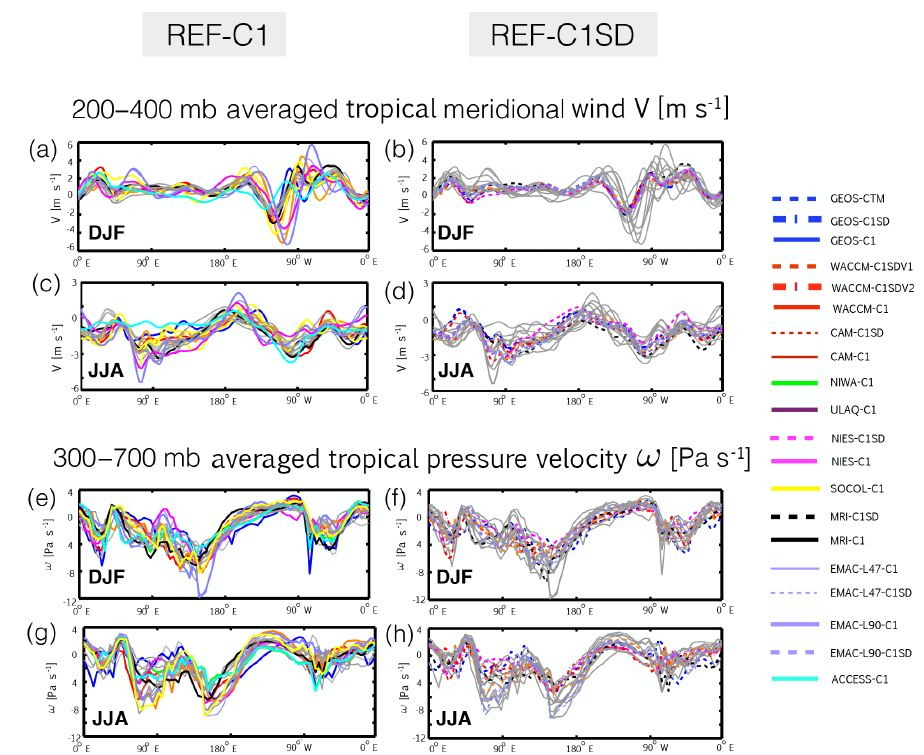
Figure 10. Comparisons of the upper tropospheric meridional wind V (a–d) and 300–700hPa averaged pressure velocity (e–h) among the simulations. The REF-C1 and REF-C1SD simulations are shown in panels (a, c, e, g) and (b, d, f, h) , respectively. The grey lines denote the C1SD (C1) simulations in the left (right) panels in order to a provide a sense of the ensemble